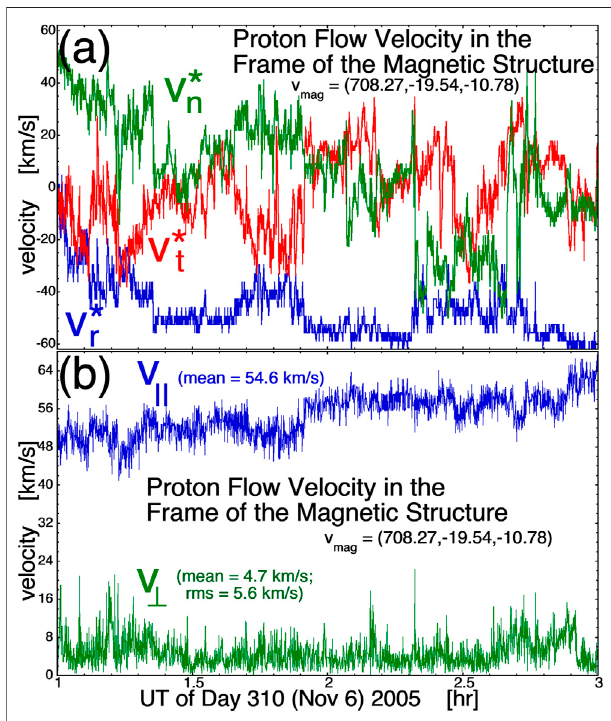
FIGURE13| A2-hintervalofAlfvéniccoronal-hole-originplasmaseenat 1 AU using 3-s measurements from WIND. The measurements for the 2 h are shifted into the reference frame of the magnetic structure by subtracting off (708.27, − 19.54, − 10.78) km/s. Panel (A) plots the RTN components of the proton fl ow in the frame of the magnetic structure and Panel (B) the 3-s fl ow measurements are decomposed in parallel-to- B and perpendicular-to- B components using 3-s measurements of the magnetic- fi eld